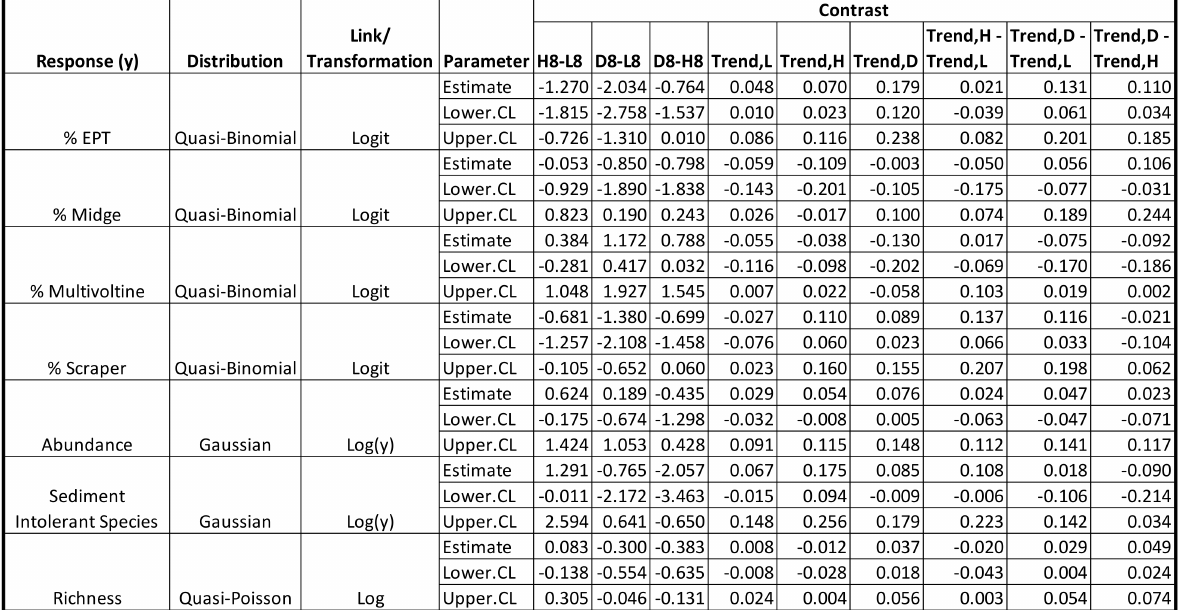
Figure A2. Contrasts of biotic characteristics from 2008 to 2016 at low flood ( L ), high flood ( H ), and debris flow ( D ) disturbance categories. First set estimate difference between each category immediately after storm, the second the difference trend at H, L, and D and the third comparing